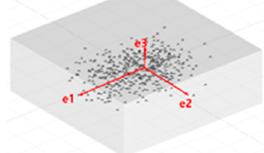
Figure 3. PCA eigenvector estimation.